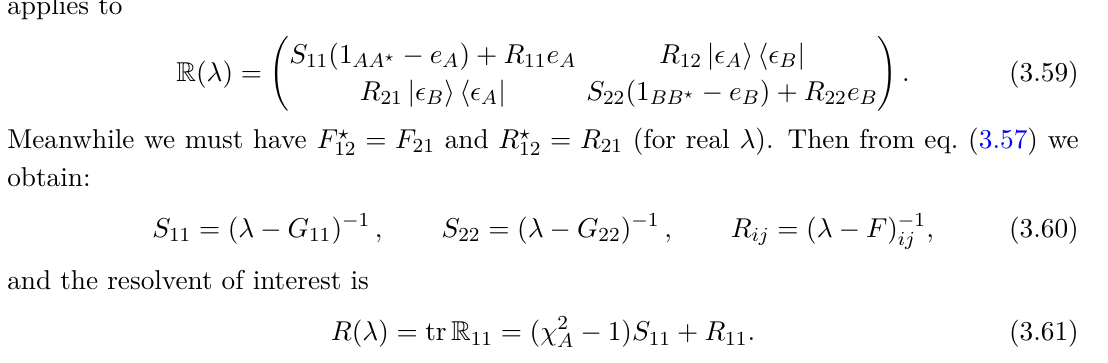
= | (cid:15) i ), e i h (cid:15) | B A A A etc. A similar AA ?